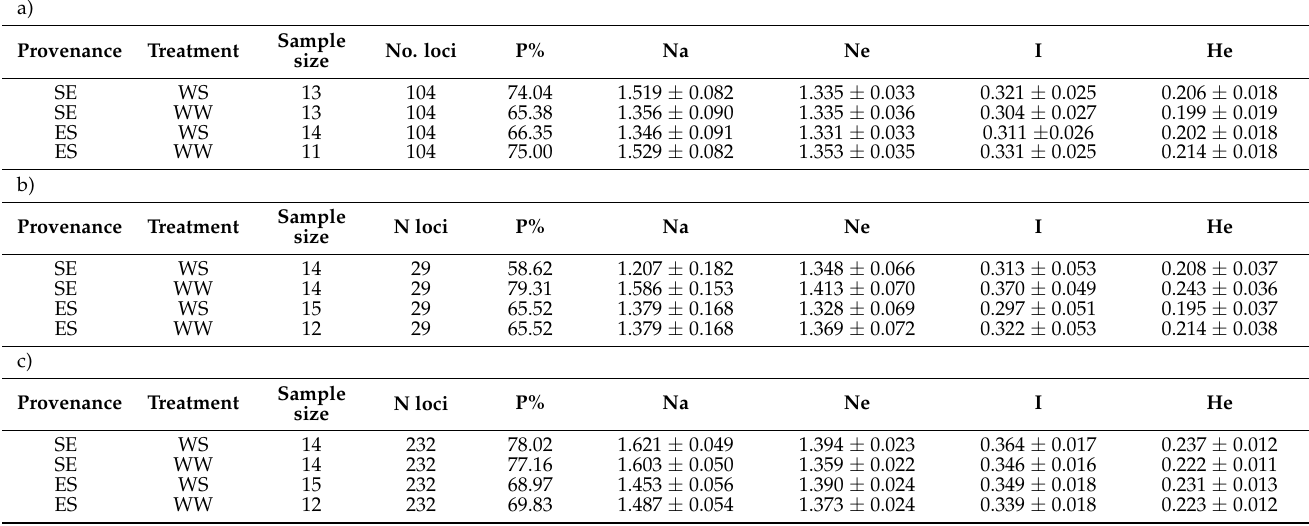
Table 8. Epigenetic (a) and genetic (b,c) diversity parameters estimated for well-watered (WW) and water-stressed (WS) seedlings of Spanish (ES) and Swedish (SE) provenances using MSAP-MSP (a), MSAP-MIP (b) and AFLP (c) markers. No. loci = Number of loci; P% = Percentage of polymorphics fragments; I = Shannon’s diversity index; Na = Number of alleles; Ne = Number of effective alleles; He = Expected Heterozygosity , (mean values ±